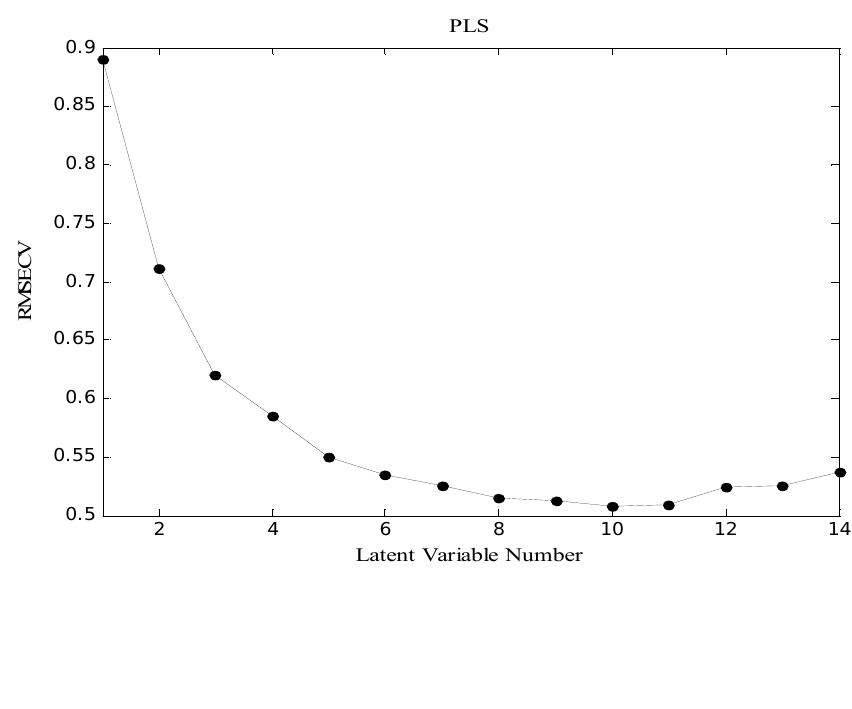
Figure 5. The RMSECV versus number of